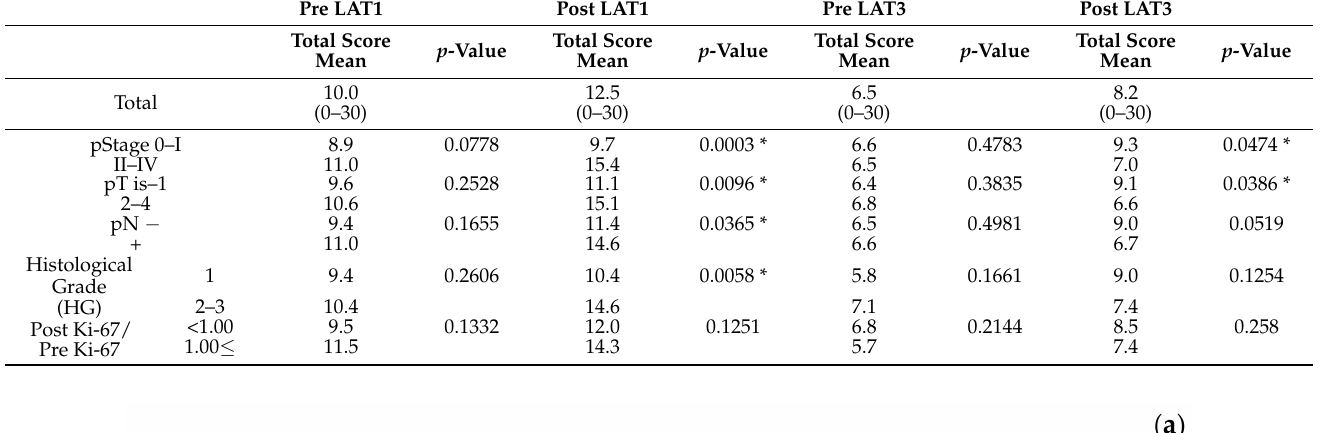
Table 3. Clinicopathological features according to the status of LAT1 and LAT3 (Cohort 2, n = 84). The data was analyzed by the Student’s t-test. * p < 0.05.